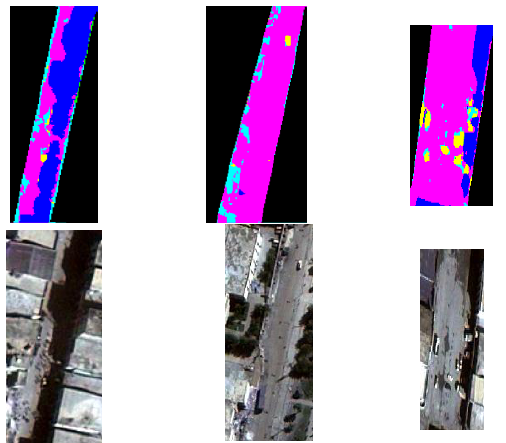
Fig 6. Some paths deemed un-blocked by the